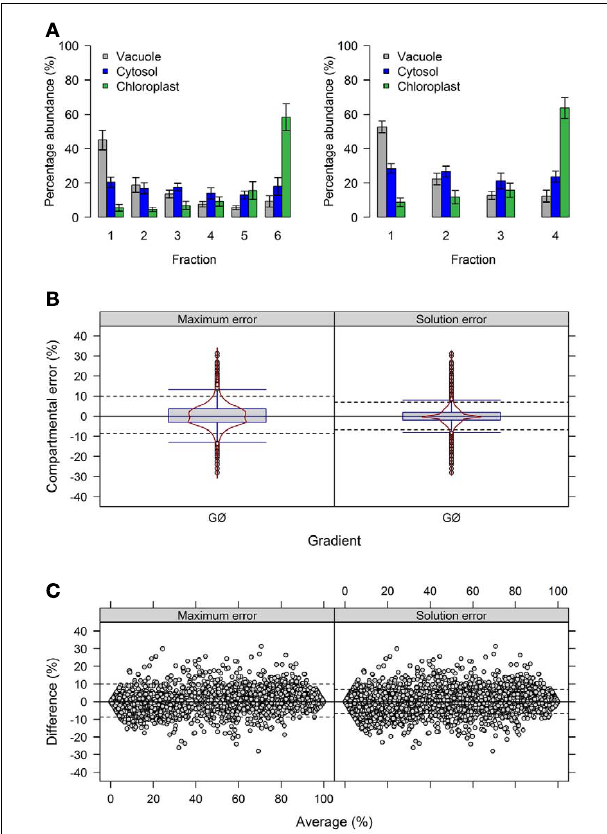
FIGURE 5 | Influence of the number of collected fraction on estimated compartmental abundances based on experimental data. (A) Bar plots depicting the mean–averages and SDs of the three compartment-specific markers for each of the three resolved compartments on the basis of 6 and 4 collected fractions. Neighboring terminal fractions, i.e., 1 + 2 and 5 + 6, were averaged to obtain results for 4 fractions. (B) Combined box- and violin plots (red lines) as well as (C) mean-difference plots showing the difference of the maximum and solution error based on compartmental abundances estimated using BFA for gradients comprising 6 and 4 fractions. For both, positive values indicate larger compartmental abundances for 6 fractions while negative values depict larger abundances for 4 fractions.The 5th and 95th percentiles are drawn as black dashed lines.The figures show the average of three independent